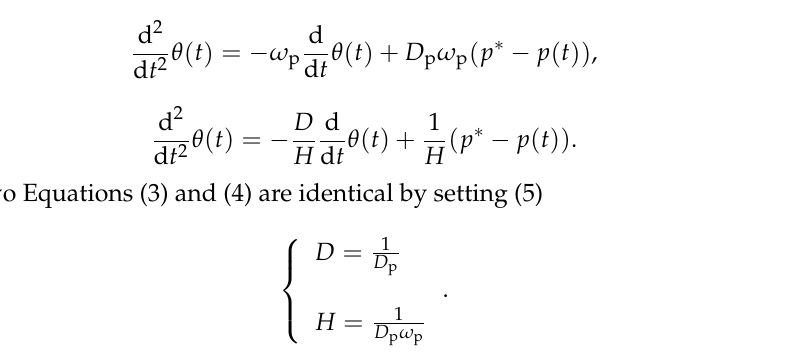
large-signal sense as long as (5) is satisfied. Therefore, the droop control with a first-order low-pass filter is used for subsequent investigations in this